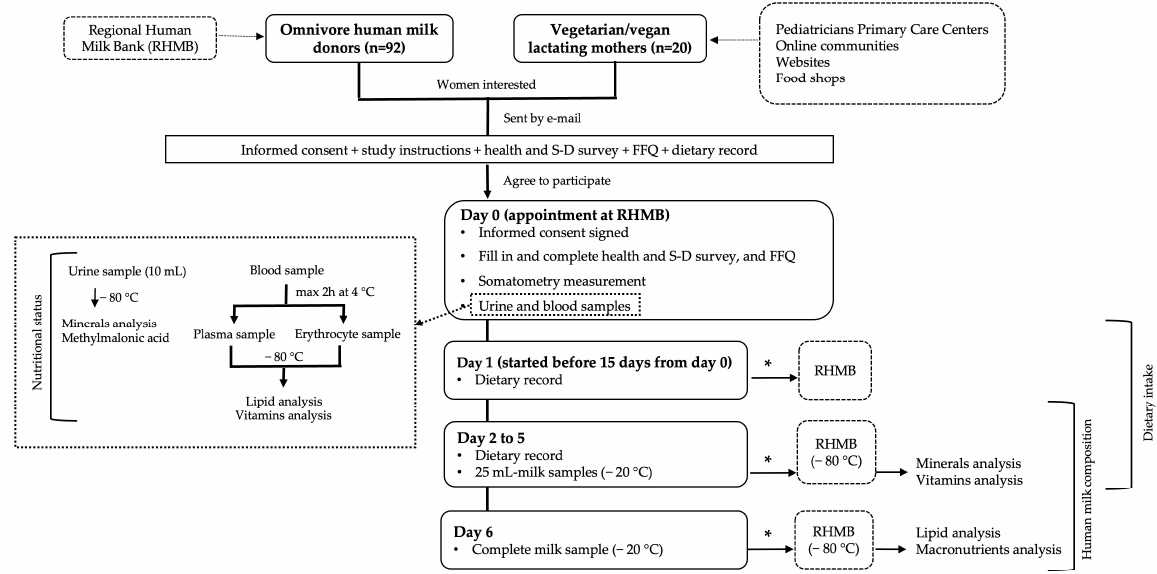
Figure 1. Flow chart of the study’s protocol. * Delivered to the RHMB within the following 15 days. Abbreviations: S-D, socio-demographic; FFQ, food frequency questionnaire; RHMB, Regional Hu- man Milk Bank.